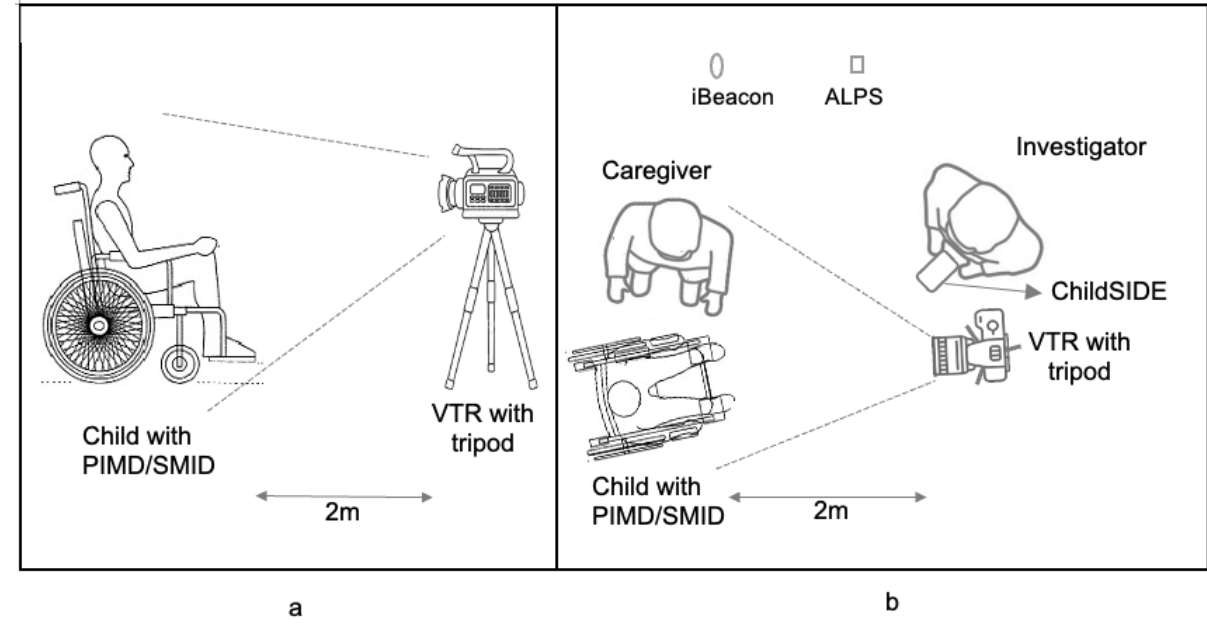
Figure 3. Intervention setup. (a) Videotape recorder (VTR) focusing on facial, and upper and lower limbs movements. (b) Intervention setup in a classroom setting: 2-meter distance from the VTR to the child with profound intellectual and multiple disabilities (PIMD) or severe motor and intellectual disabilities (SMID) and caregiver, and the location where the iBeacon and ALPS sensors were placed.